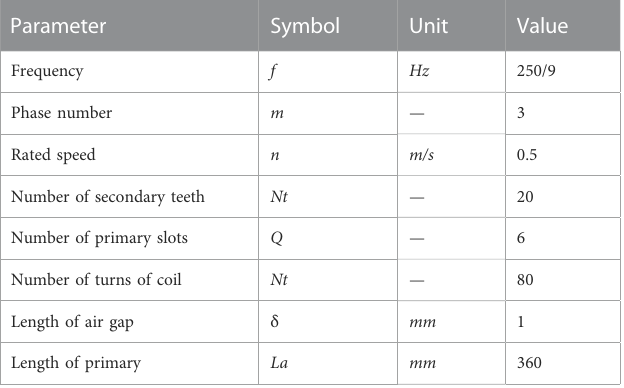
TABLE 2 The parameters of the